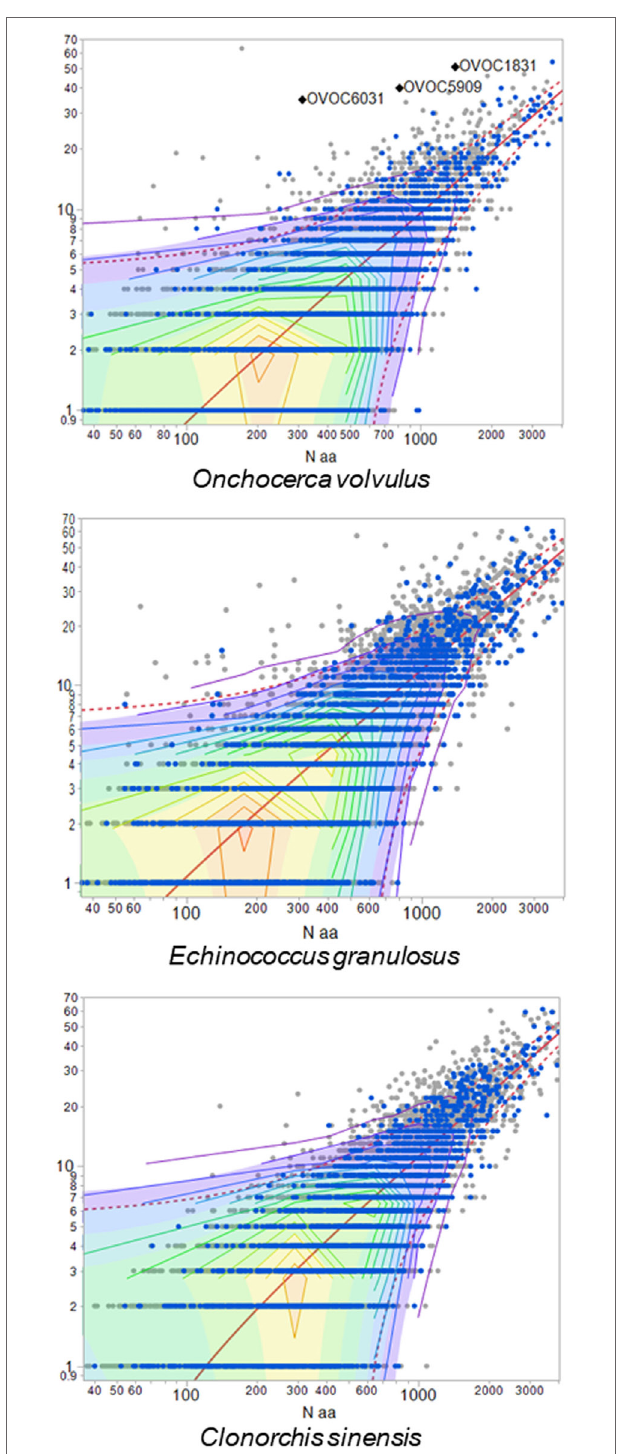
FigUre 2 | Proteins with high content of common T-cell-exposed motif (TCEM). Each dot represents one protein of the species indicated. X -axis shows size of the protein (log 10 amino acid number). Y -axis shows number of TCEM IIA motifs of higher than FC10, i.e., occurring more often than the mean in an immunoglobulinome reference database. Proteins shown in blue are secreted and surface proteins. Three example Onchocerca volvulus proteins are labeled, and sequences for these provided in Figure S3 in Supplementary Material.